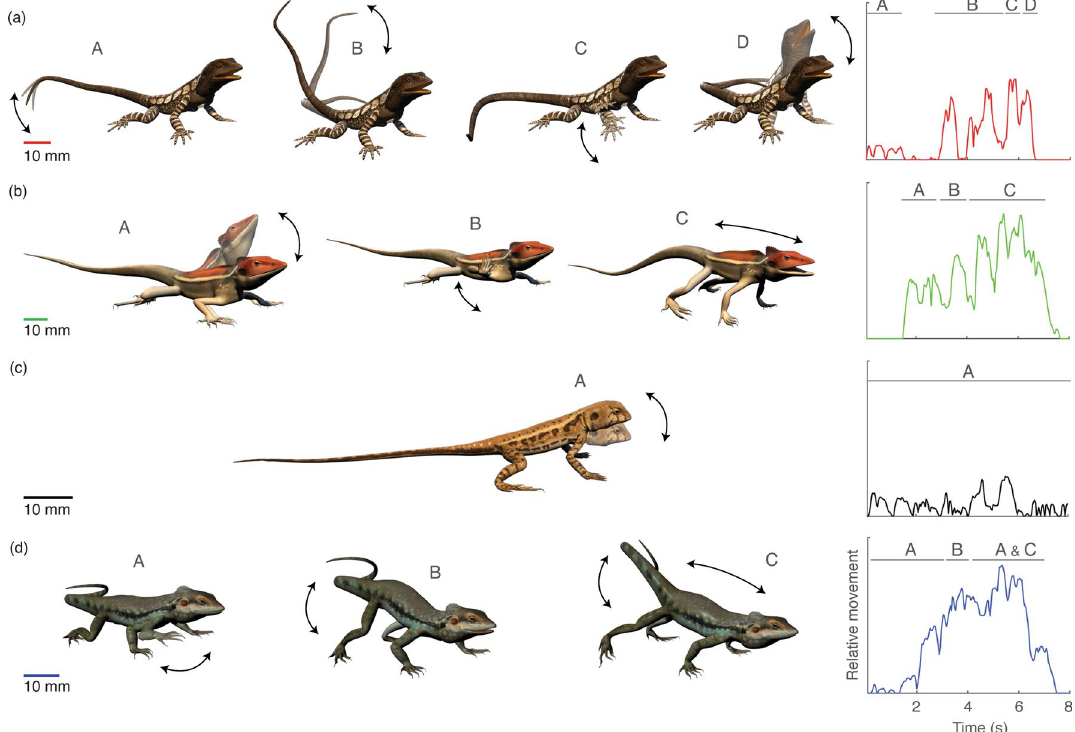
Figure 1. Images depicting the display sequences of the four lizard species used in the present study (left) accompanied by the respective temporal structure profile graph (right; see text for details). In each image set, black arrows indicate the direction of movement. Motions such as head-bobs, limb waves and tail-flicks are usually repeated for several cycles. ( a ) The display sequence of A. muricatus starts with tail-flicks (A, B), followed by limb waves (C) and finishes with a whole body movement centred on a push-up (D). The temporal structure graph indicates a relatively intermittent movement throughout the sequence. ( b ) The display sequence of G. longirostris comprises a series of head bobbing (A) and limb waving (B), the final push up is followed by a forward body thrust/rise (C). The temporal structure graph indicates relatively constant movement but with several rapid changes in movements throughout the whole sequence. ( c ) The display of C. fordi is comparatively simple, and consists of rapid movement of the head up and down (head-bobbing, A). The temporal structure graph indicates a relatively continuous movement throughout the sequence. ( d ) The display sequence of C. decresii comprises with several limb waves (A) and a distinct raising of the tail with a coil at the distal end of the tail (B), it finishes with a forward body thrust with tail coiled (C). The temporal structure graph indicates relatively constant movement, featuring a gradual increase in the amount of body movement. Scale bars are provided for each species. Lizard images were created by the authors using Autodesk Maya 2015 (https:// www. autod esk. com. au/ produ cts/